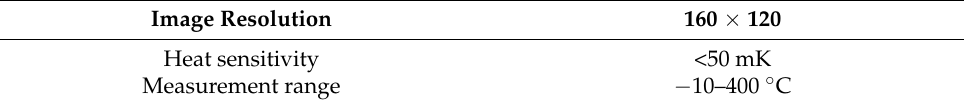
Table 2. Specification of FLIR Lepton 3.5.